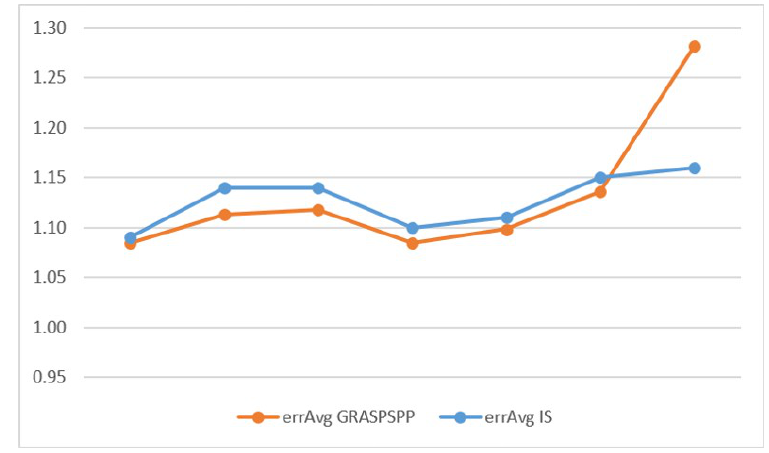
Figure 8. Average errors (errAvg) between GRASPSPP and IS.